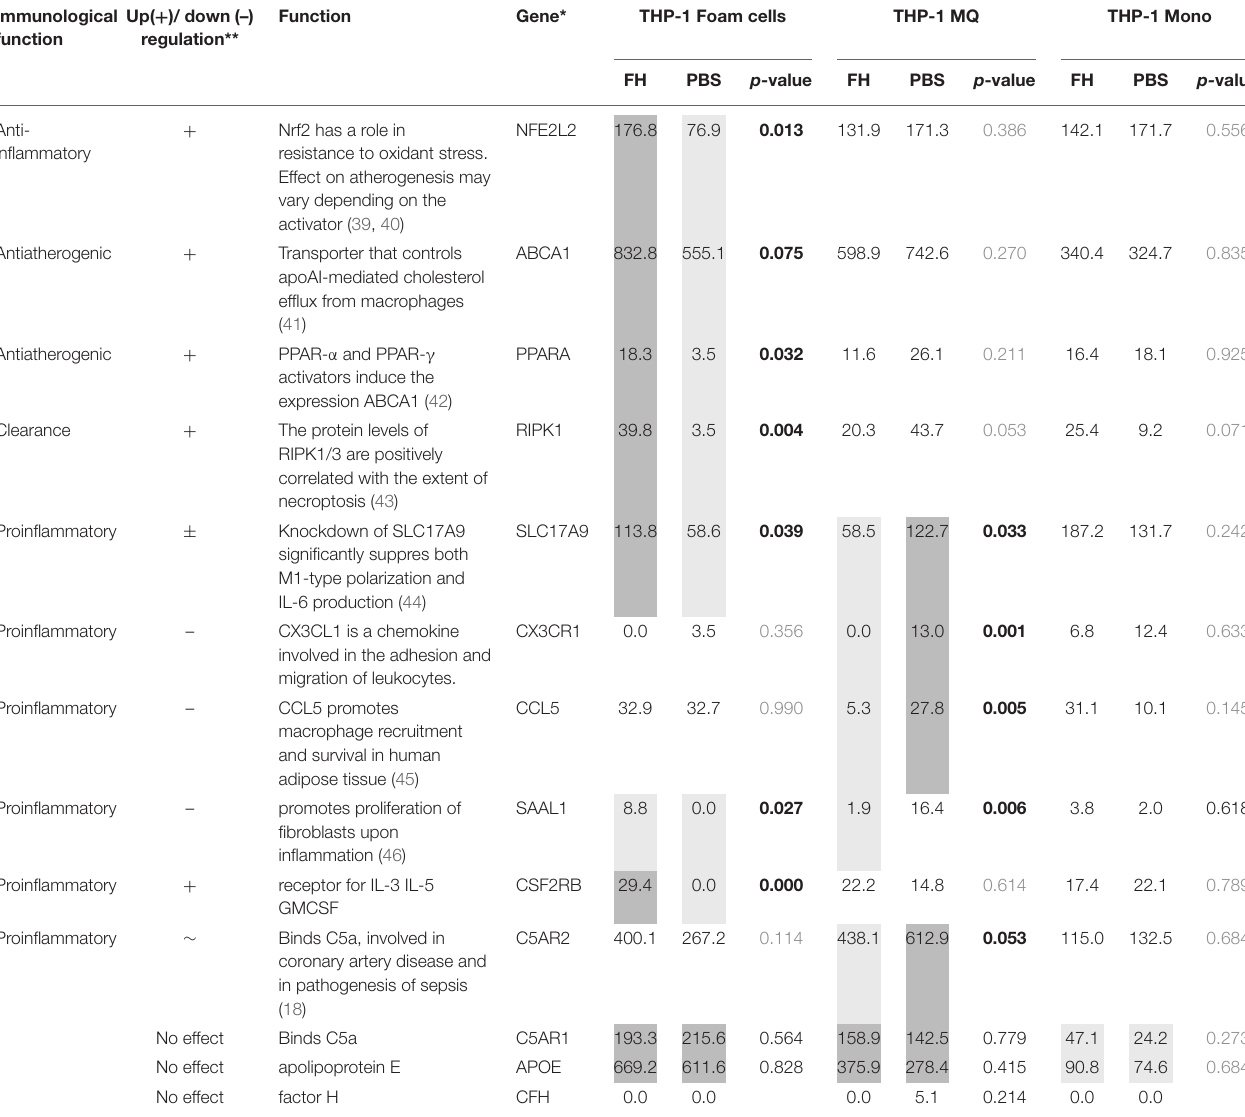
TABLE 2 | Changes in the transcriptome in response to FH in human THP-1 cells. Immunological